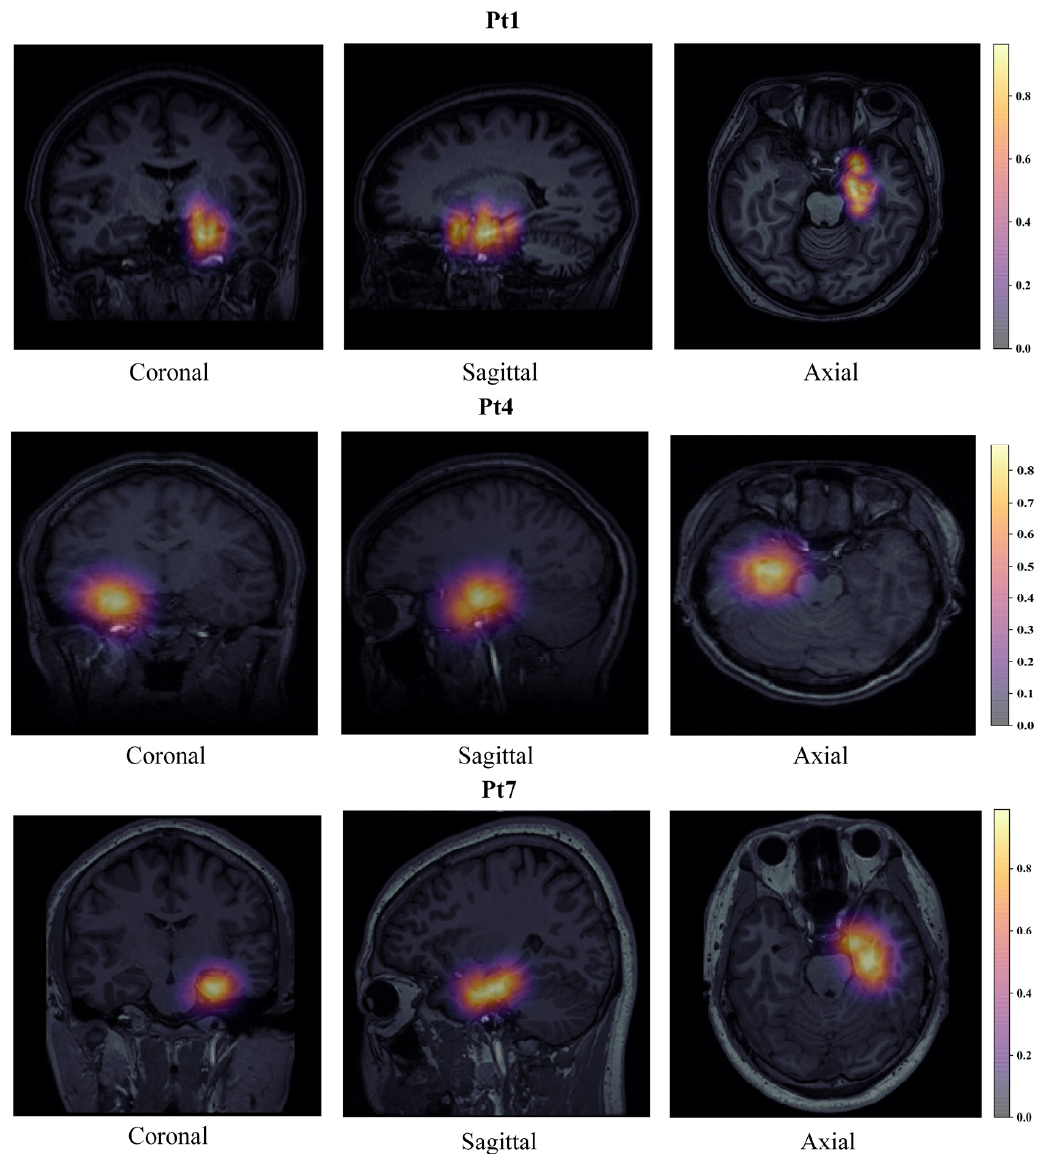
Figure 7. The SOZ prediction and visualization result with MRI from multiple axes.